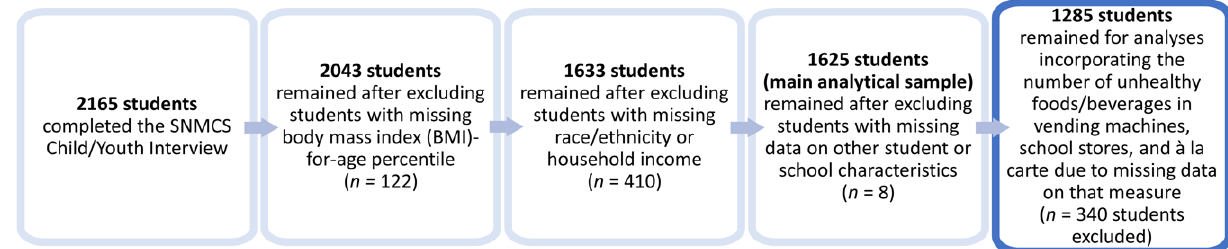
Figure 1. Sample size changes due to missing data.